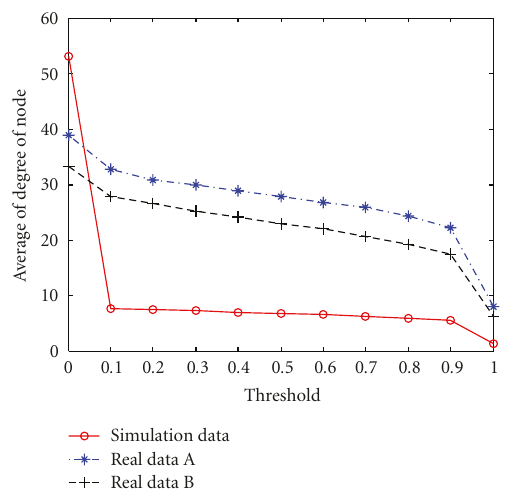
Figure 11: Variation of degree of the node with threshold.